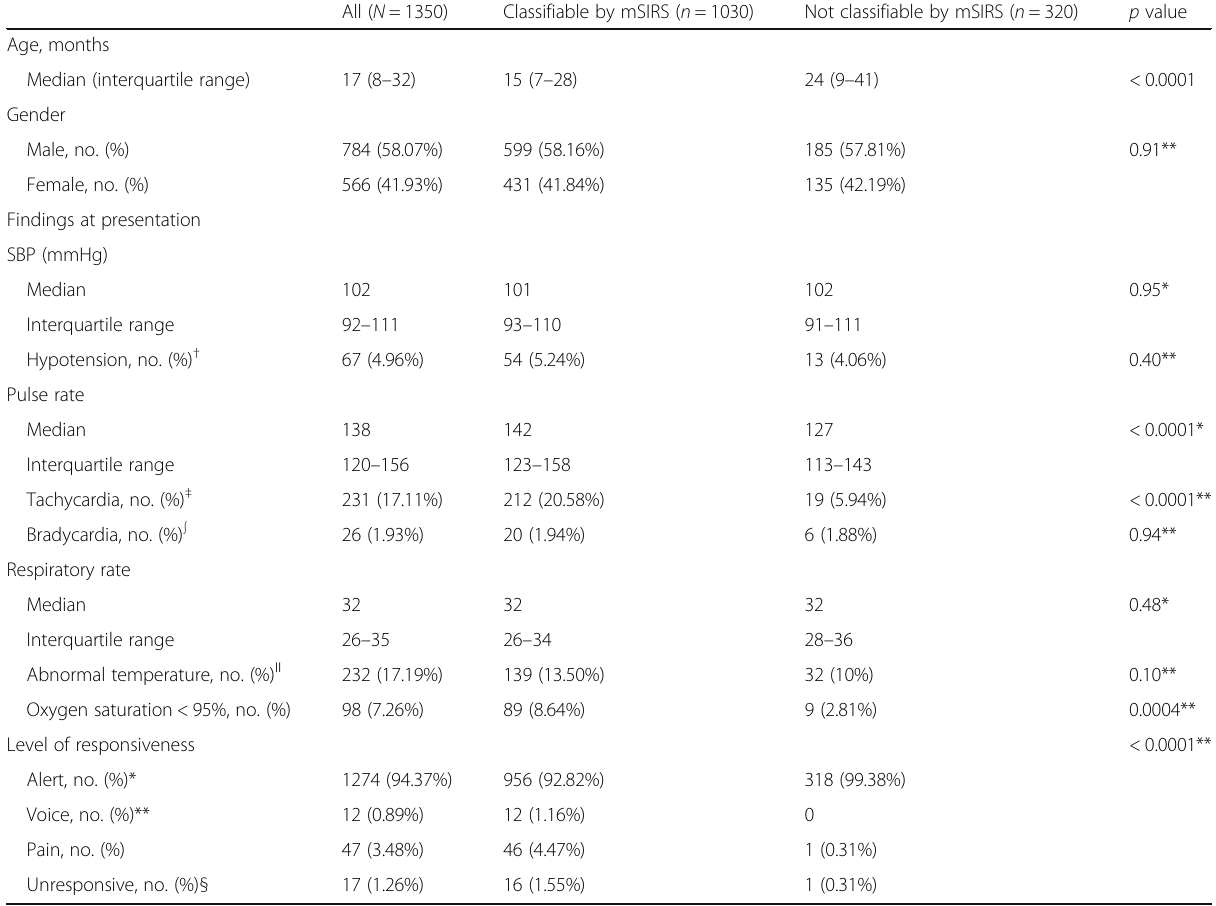
Table 1 Baseline demographic characteristics of the study